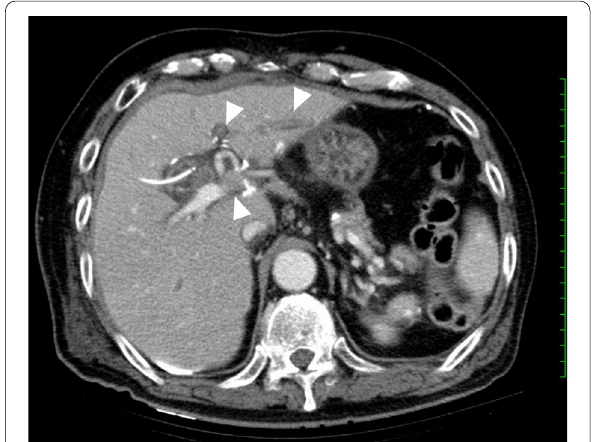
Fig. 1 Abdominal computed tomography (CT) images of case 1. An enhanced abdominal CT scan showed thrombosis in the left and anterior segment branches of the portal vein (white triangle) on POD